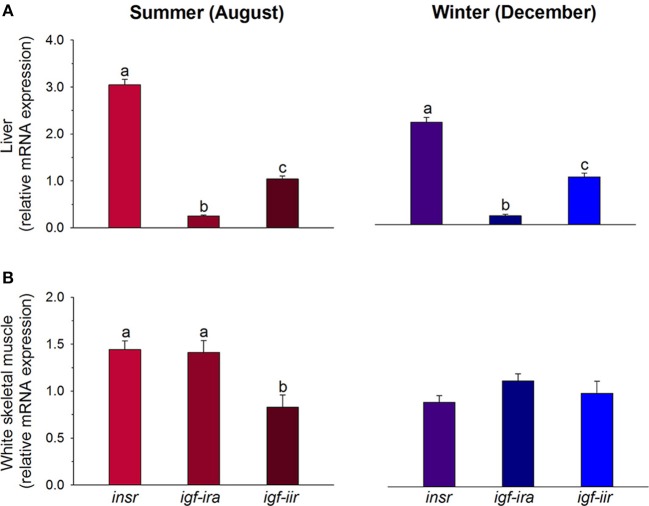
Regulated gene expression of receptors of insulin (insr), igf-i (igf-ira), and igf-ii (igf-iir) in liver (A) and skeletal muscle (B) of gilthead sea bream juveniles during summer (red colors) and winter (blue colors). For each tissue and season, data values (mean ± SEM, n = 6–7) are normalized to the expression level of igf-iir (arbitrary value of 1). Different superscript letters indicate significant differences (P < 0.05; ANOVA followed by Student-Newman–Keuls test). Data derived from samples from Benedito-Palos et al. (146).